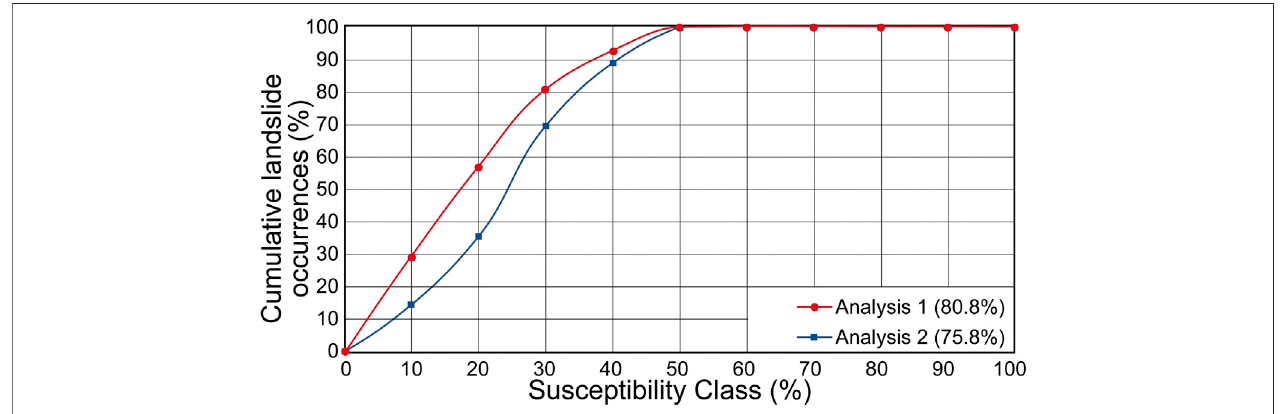
FIGURE 5 | Plot of cumulative percentage of landslide occurrences vs. percentage of landslide susceptibility classes. The success rate is calculated as the area underthecurve.Analysis1wascalculatedfromthesixinitialparameters(geologyand geomorphology,distancetolineament,slopegradient, elevation,slopecurvature, and slope aspect) and in analysis 2, slope aspect was replaced with planar failure